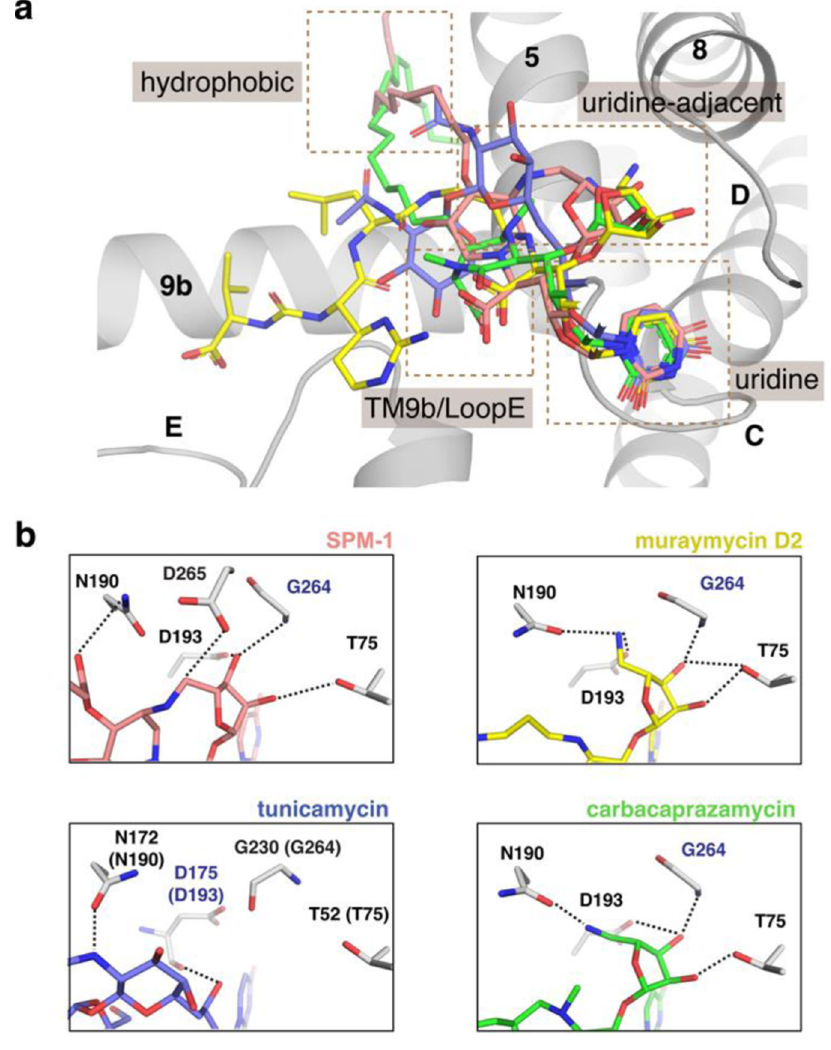
Fig. 6 | Structural comparison of MraY bound to SPM-1, muraymycin D2, car- bacaprazamycin, and tunicamycin. a Structural superimposition of SPM-1- CB complexes. The binding sites recognized by each inhibitor on the cyto- plasmic side of MraY AA include the uridine, uridine-adjacent, TM9b/Loop E), and